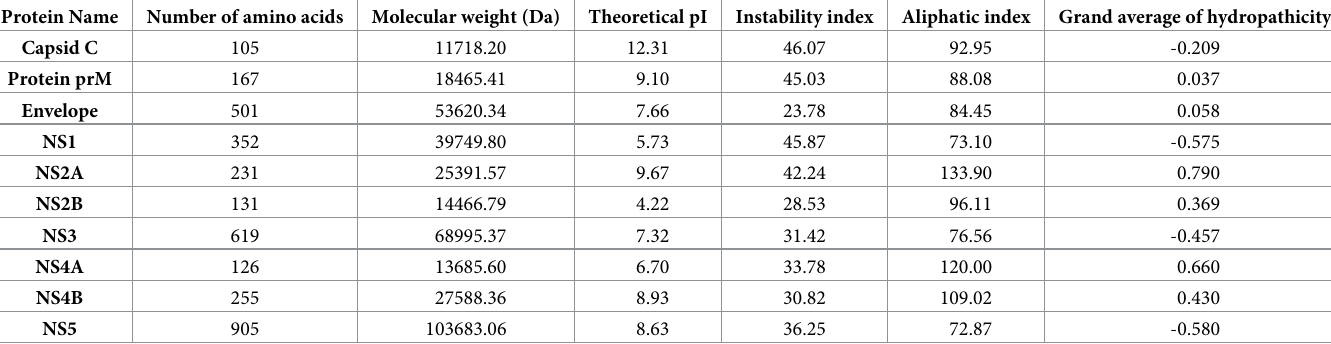
Table 1. Physiochemical parameters of structural and non-structural protein of West Nile virus.